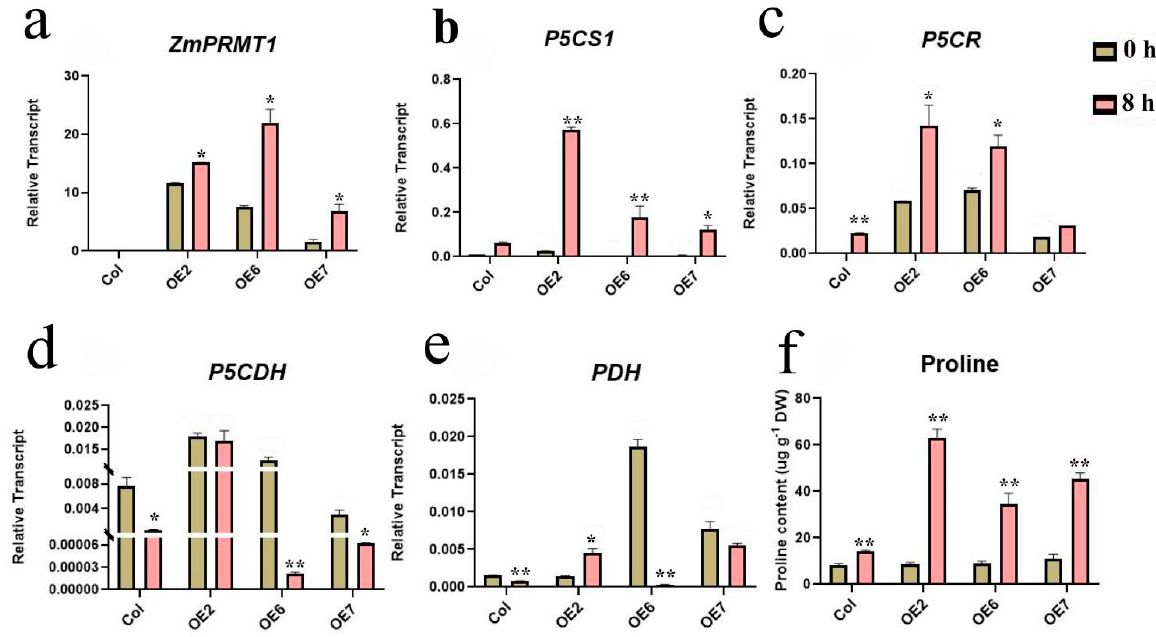
Figure 11. Analysis of heat tolerance-related genes expression and proline accumulation under heat stress by qRT-PCR. The plant abiotic stress tolerance-related genes, including genes in the proline synthesis way such as ( b ) P5CS1 (AT2G39800), delta1-pyrroline-5-carboxylate synthase 1; ( c ) P5CR (AT5G14800), pyrroline-5-carboxylate (P5C) reductase and genes in the proline degradation way such as ( d ) P5CDH (AT5G62530), DELTA1-PYROLINE-5-CARBOXYLATE DEHYDROGENASE; ( e ) PDH (AT3G30775) and PROLINE DEHYDROGENASE. The mRNA levels were determined using qRT-PCR, and the values are reported relative to ZmPRMT1 mRNA levels in each line ( a ). The proline accumulation contents were shown in ( f ). Error bar is generated by three biological repetitions. The significance level is indicated by the asterisk at the top of the error bar. p < 0.05 is significantly different *; p < 0.01 is significantly different **.